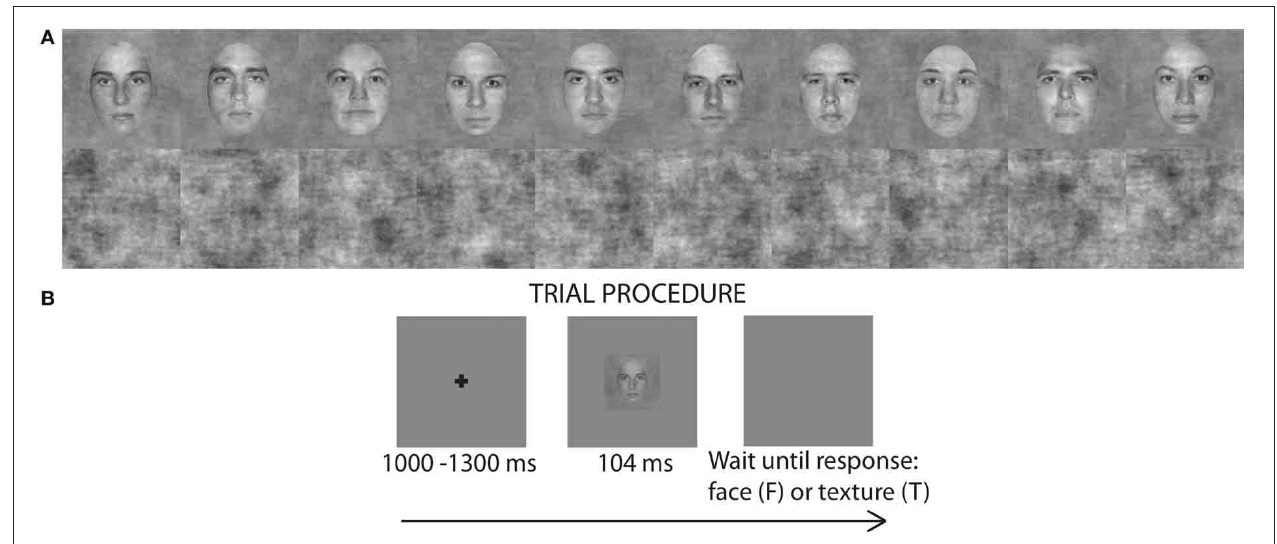
FIGURE 1 | (A) 10 face identities at 70% phase coherence and 10 examples noise textures (0% phase coherence) used in the luminance experiment. (B) Single trial procedure. For presentation purposes the fixation cross and the face image are not to scale.